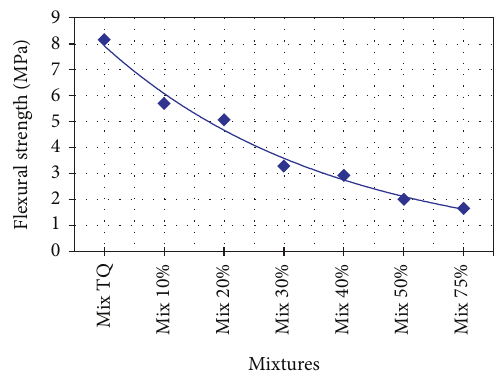
Figure 6: Flexural strength of rubber cement composites on day 60.